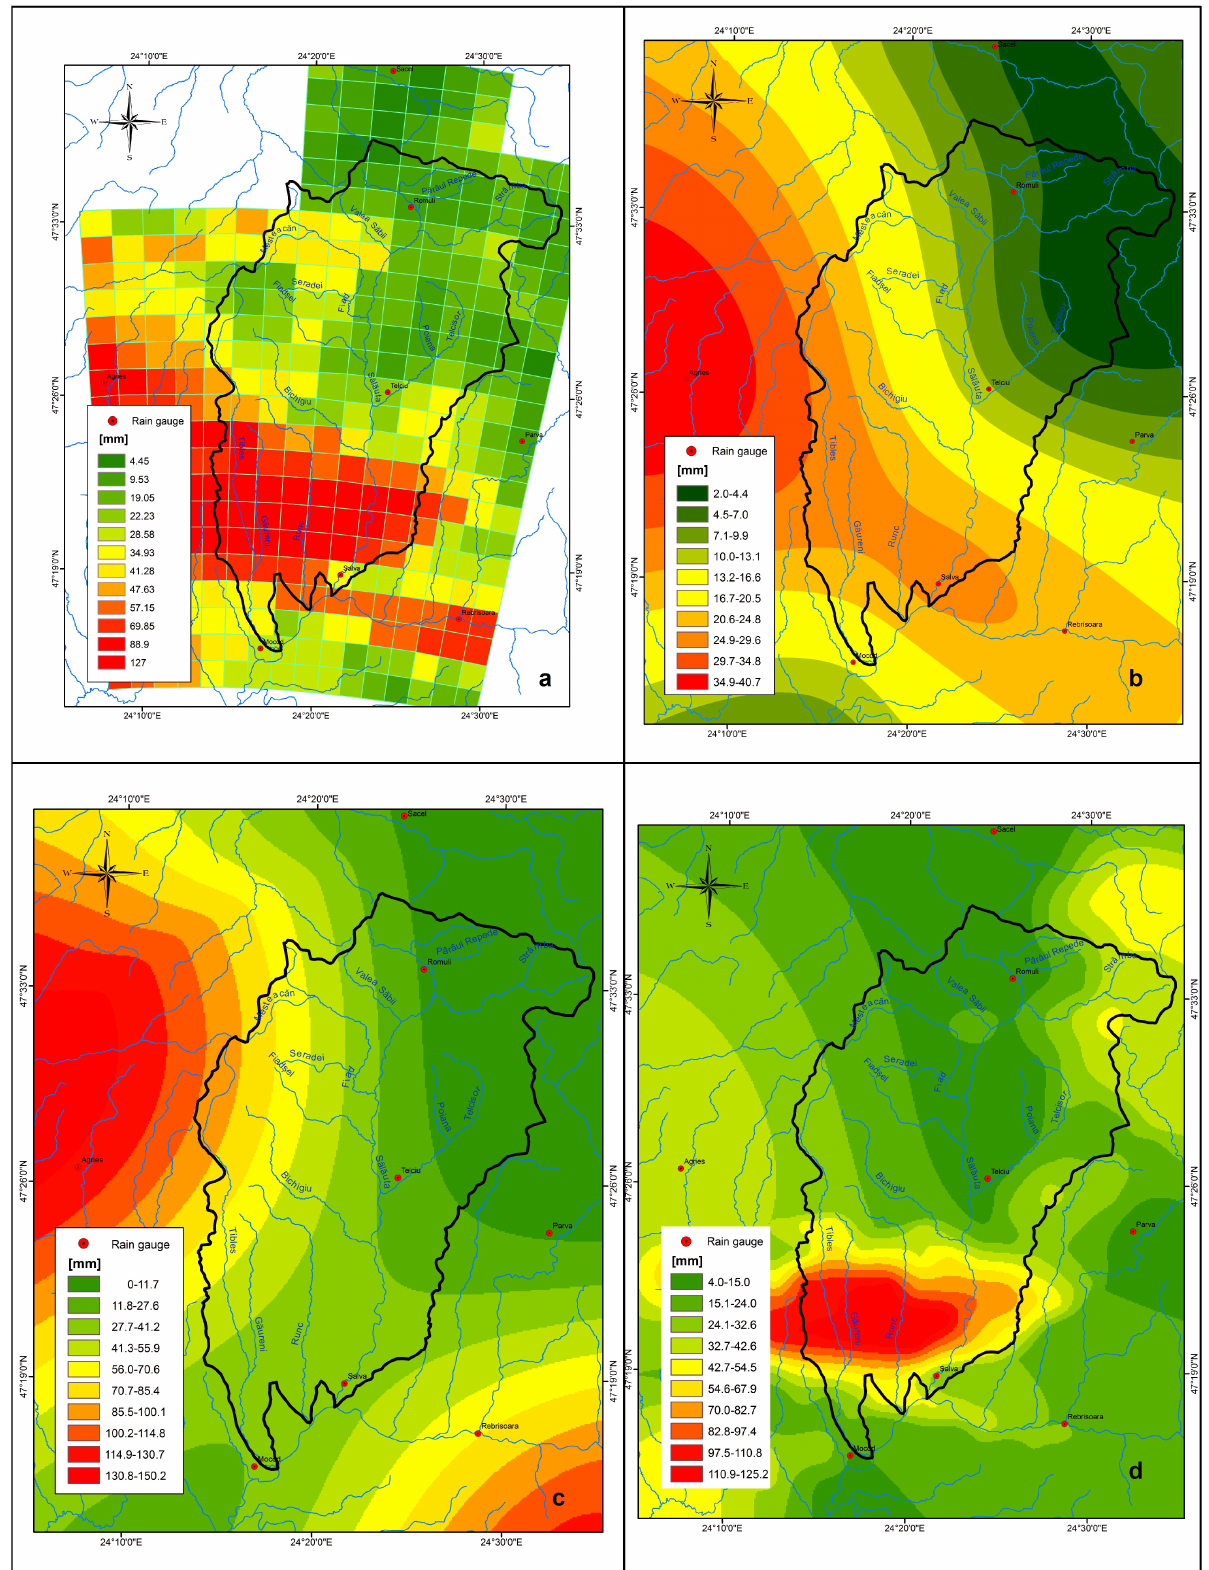
Figure 4. Conditional merging process: ( a ) rainfall estimated by radar; ( b ) rainfall measured by rain gauges and kriged at the resolution of the radar pixel; ( c ) rainfall estimated by the radar at the rain gauge locations and kriged; ( d ) final rainfall field estimated by the conditional merging